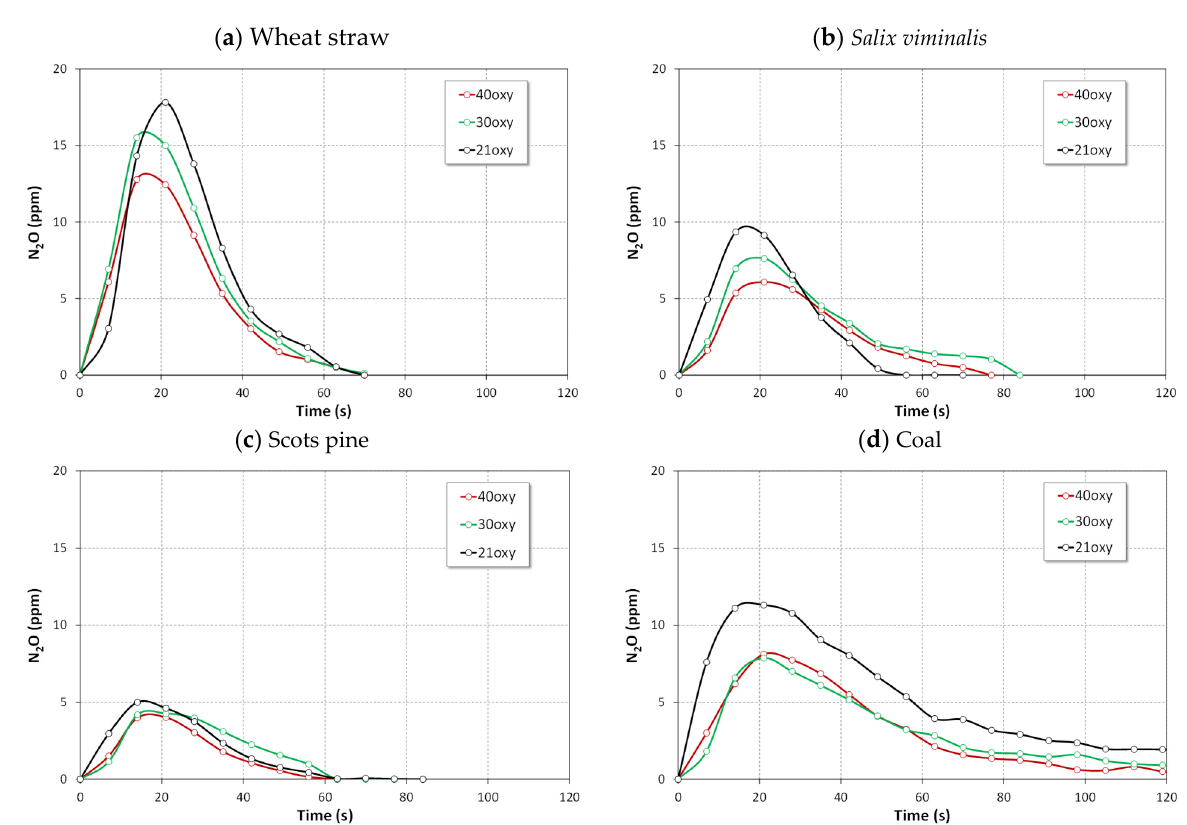
Figure 8. The instantaneous concentrations of NO during oxy-combustion of tested fuels.